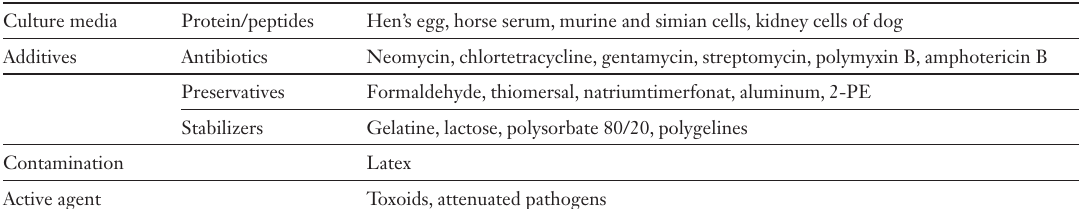
Components of vaccines